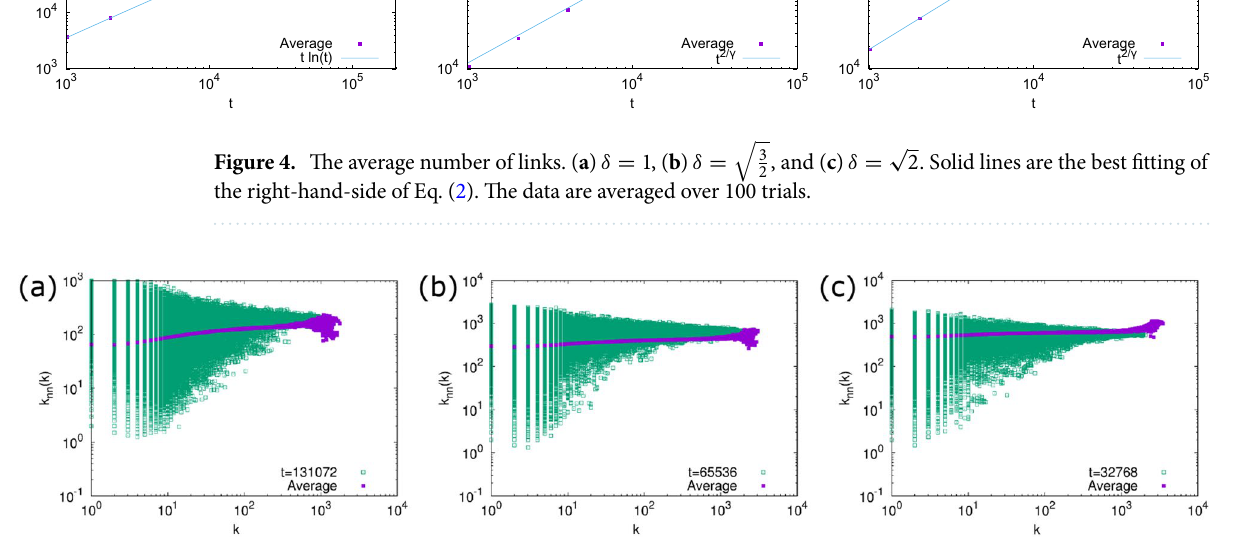
Figure 5. The degree correlation function k nn ( k ) of the generated networks at the final time step in the numerical simulation. ( a ) δ filled squares are the average over 100 trials.